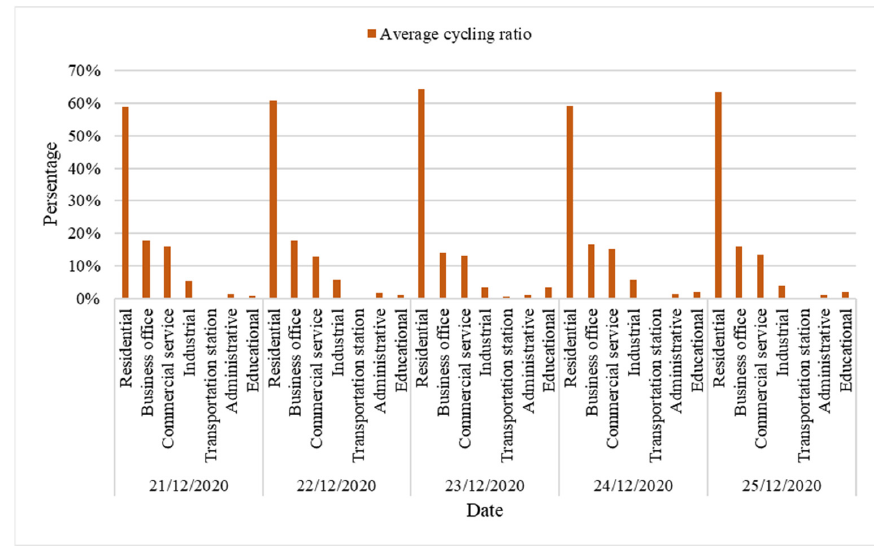
Figure 13. The fluctuation in cycling ratio for land use pattern.